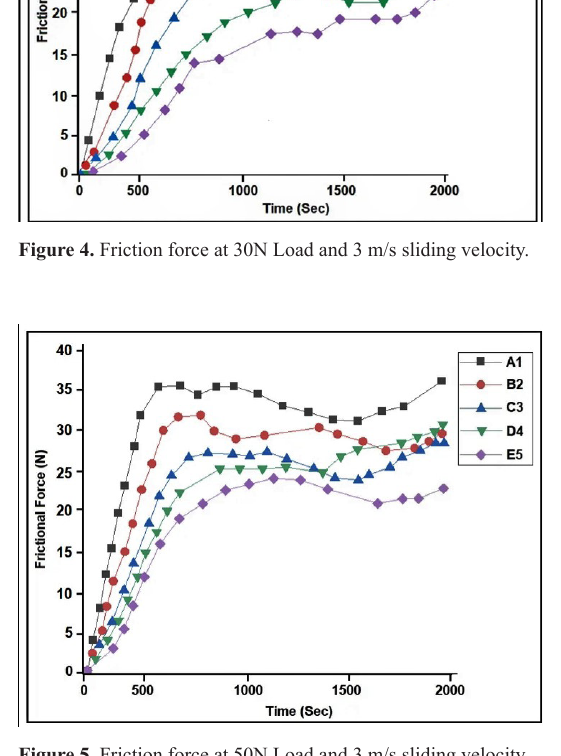
Figure 5. Friction force at 50N Load and 3 m/s sliding velocity.